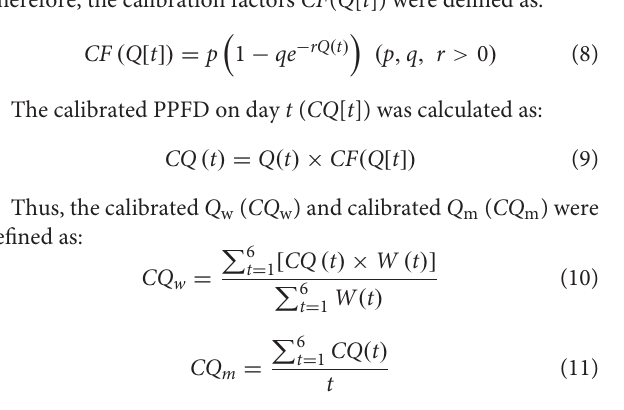
Supplementary Figure 2 . Calibrated leaf CO 2 response